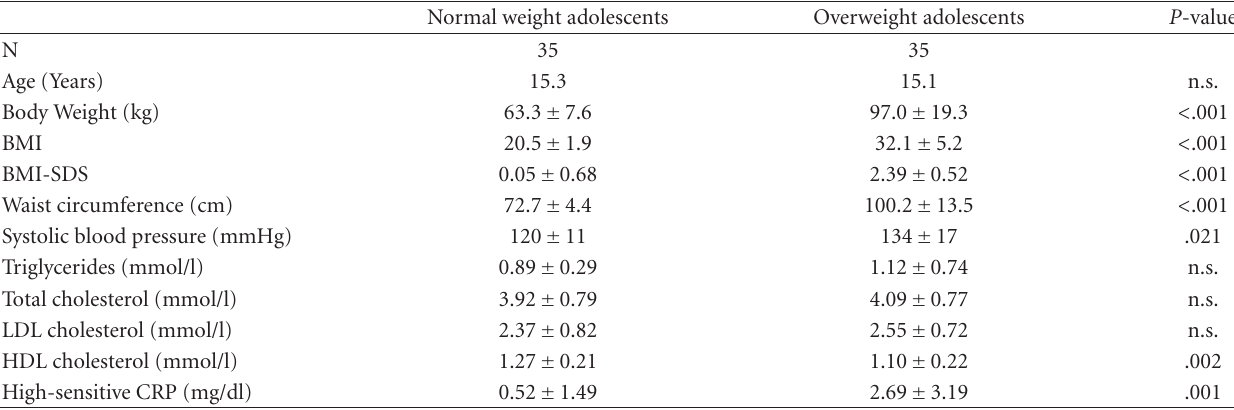
Table 1: Characteristics of the study population. Data are presented as mean ± standard deviation. n.s.: not significant.